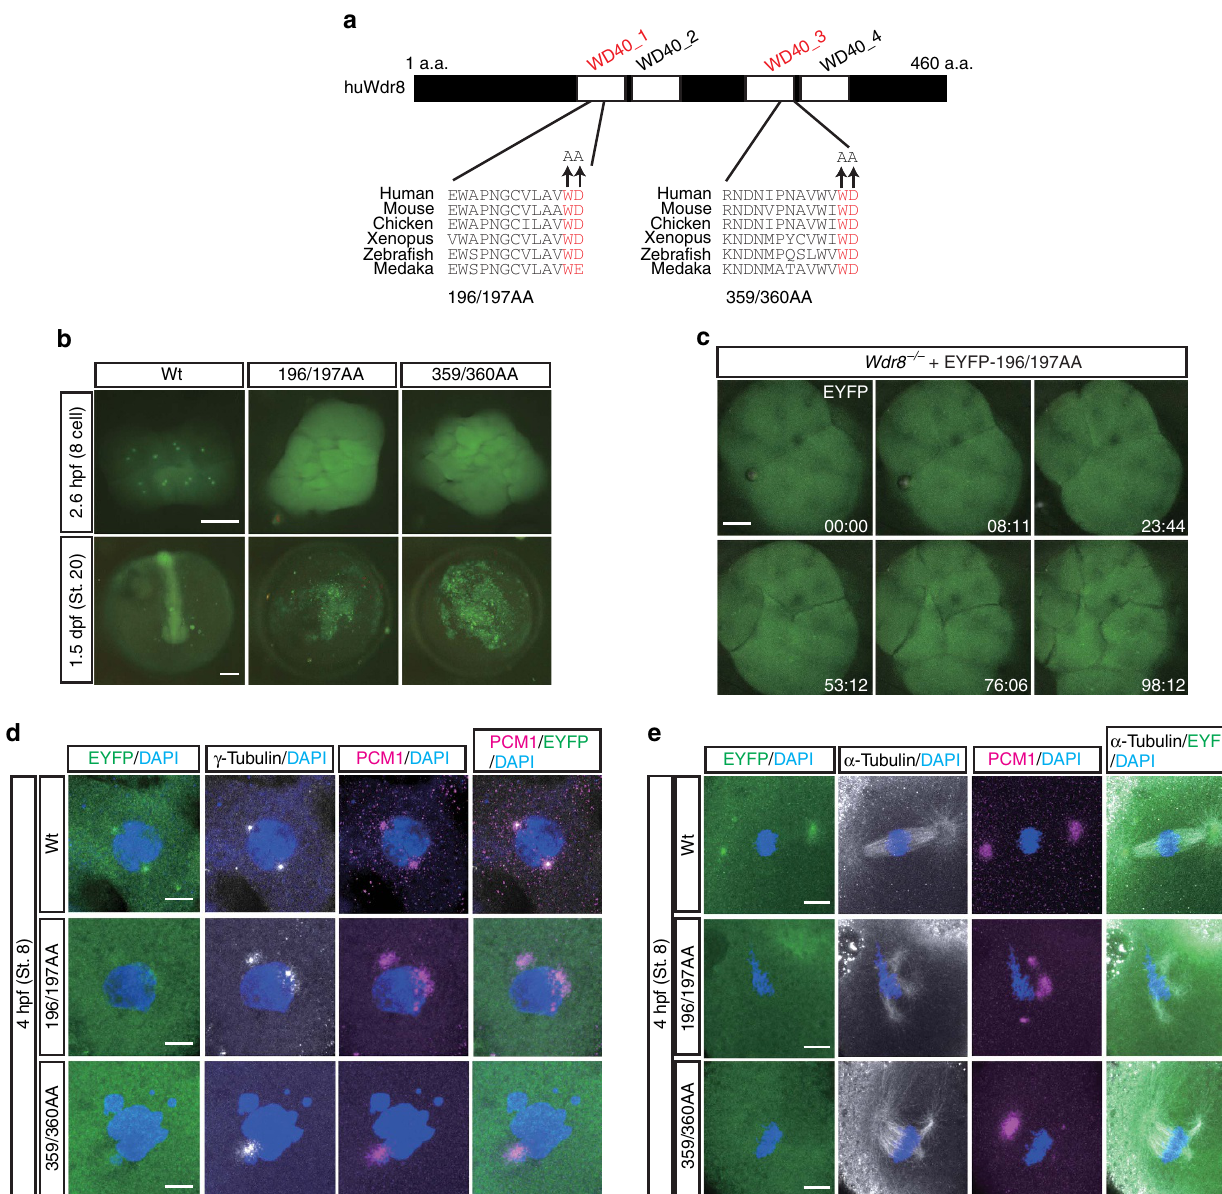
Figure 4 | WD40 domains are essential for Wdr8 function. ( a ) The conserved four WD40 domains in huWdr8. Mutations for WD mutant variants are denoted in red. ( b ) External phenotypes of WD mutant-injected Wdr8 (cid:2) / (cid:2) zygotes and embryos. Note that both variants mostly localised in the cytoplasm (2.6hpf), unable to rescue Wdr8 (cid:2) / (cid:2) embryos (1.5dpf). ( c ) Time-lapse images of EYFP-196/197AA localisation in Wdr8 (cid:2) / (cid:2) blastomeres. EYFP-196/ 197AA weakly localised to the centrosome with multiple foci, which disappeared during cleavages. Time, min. ( d , e ), In comparison with EYFP–huWdr8 wild-type, expression of either mutant variant was unable to rescue abnormal PCM assembly ( g -tubulin/PCM1), multipolar mitotic spindles, and chromosome alignment defects. Scale bars, 200 m m ( b ), 100 m m ( c ) and 10 m m ( d , e ). Stages are denoted as hours/days post fertilisation (hpf, dpf) and the corresponding stage of WT are denoted in